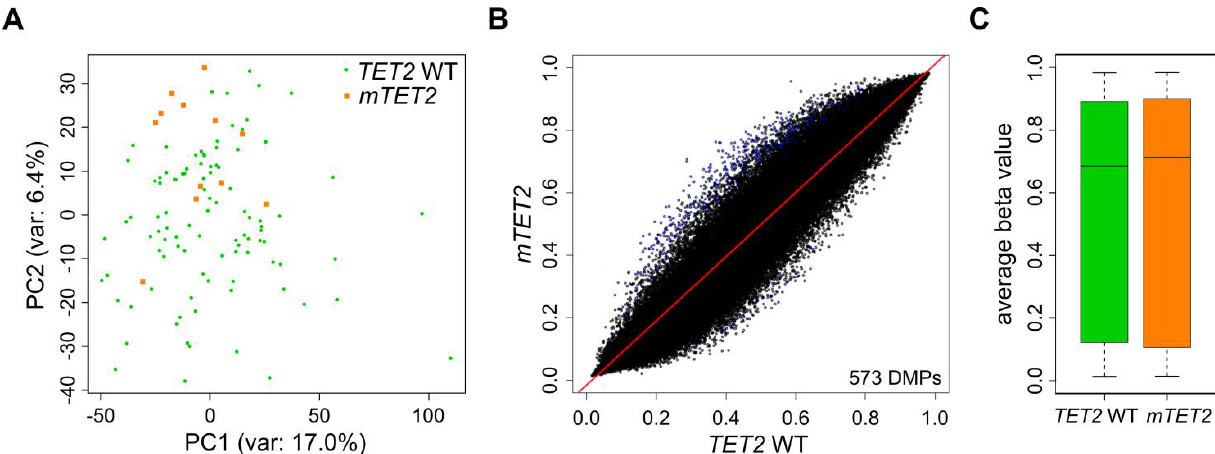
FIGURE 3: mIDH -associated hypermethylation is not replicated by TET2 mutation in AML patients. (A) Principal Component Analysis of TET2 WT and TET2 mutant AML patients using all probes retained after quality filtering. No clear separation of the two patient groups was achieved. (B) Comparison of AML patients with and without TET2 mutations by scatterplot. The average beta value of each 450K probe in the two groups is represented as a single dot. DMPs are colored in blue. IDH mutant patients were removed from the analysis. (C) Boxplot of average beta values of all probes in TET2 WT and TET2 mutant AML patients ( P =0.52).